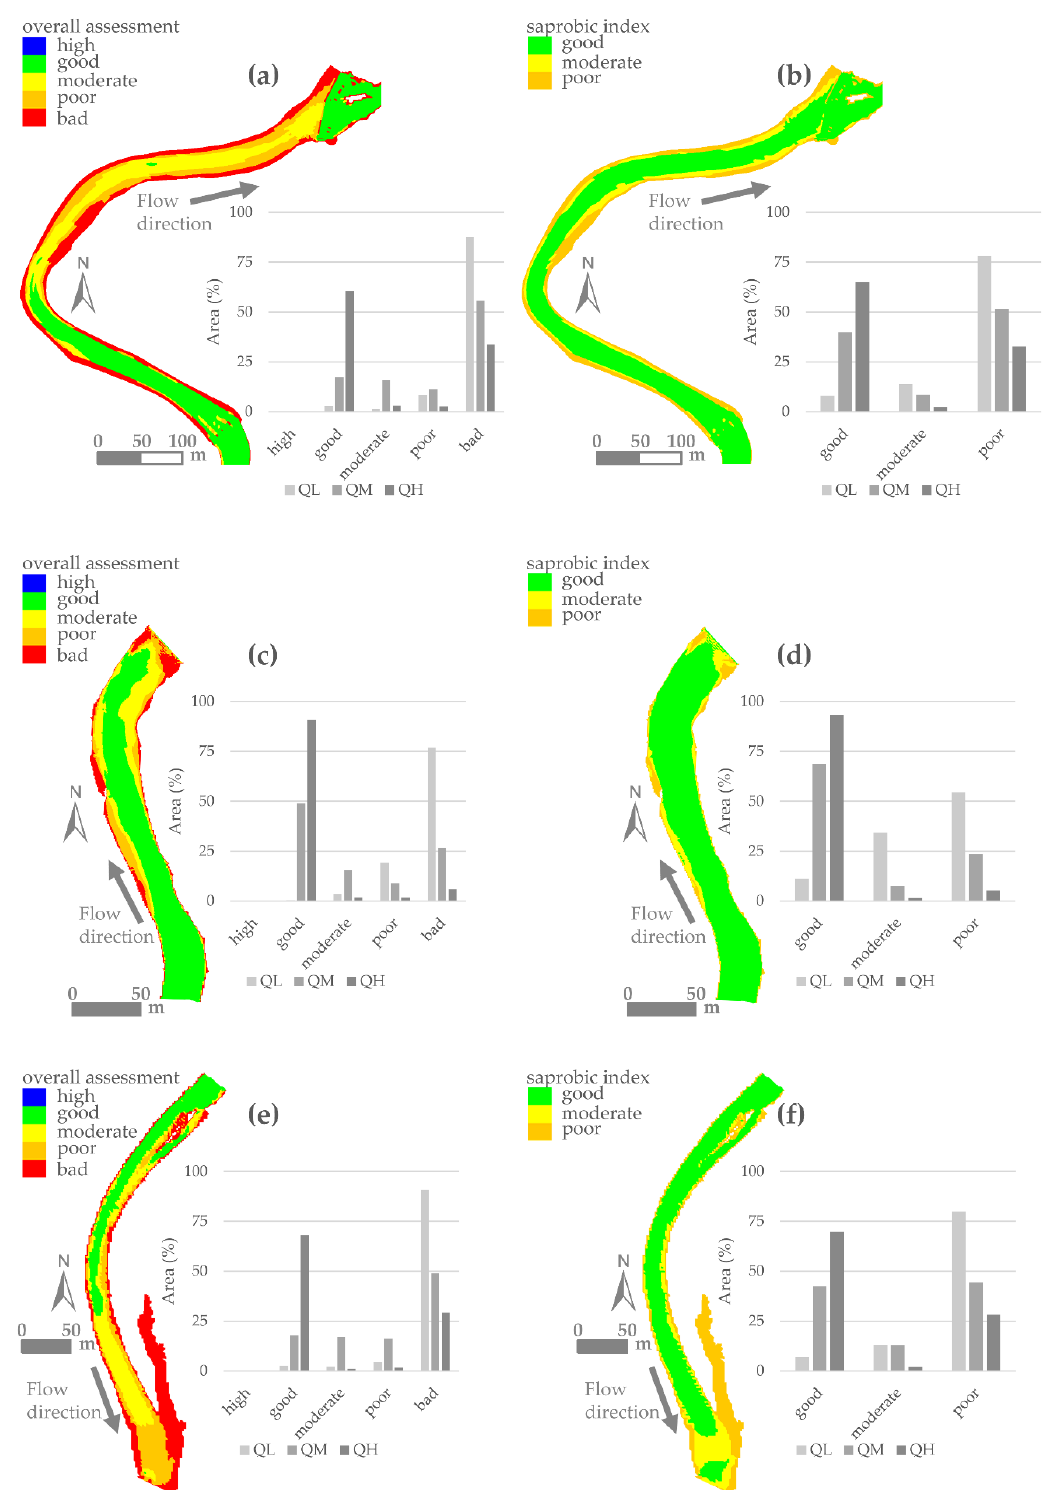
Figure 6. Results of the ecological status assessment. The overall assessment classification is shown in figure ( a ) (C.1), ( c ) (C.2), ( e ) (C.3). Results based on the saprobic index evaluation are shown in figure ( b ) (C.1), ( d ) (C.2), ( f ) (C.3).